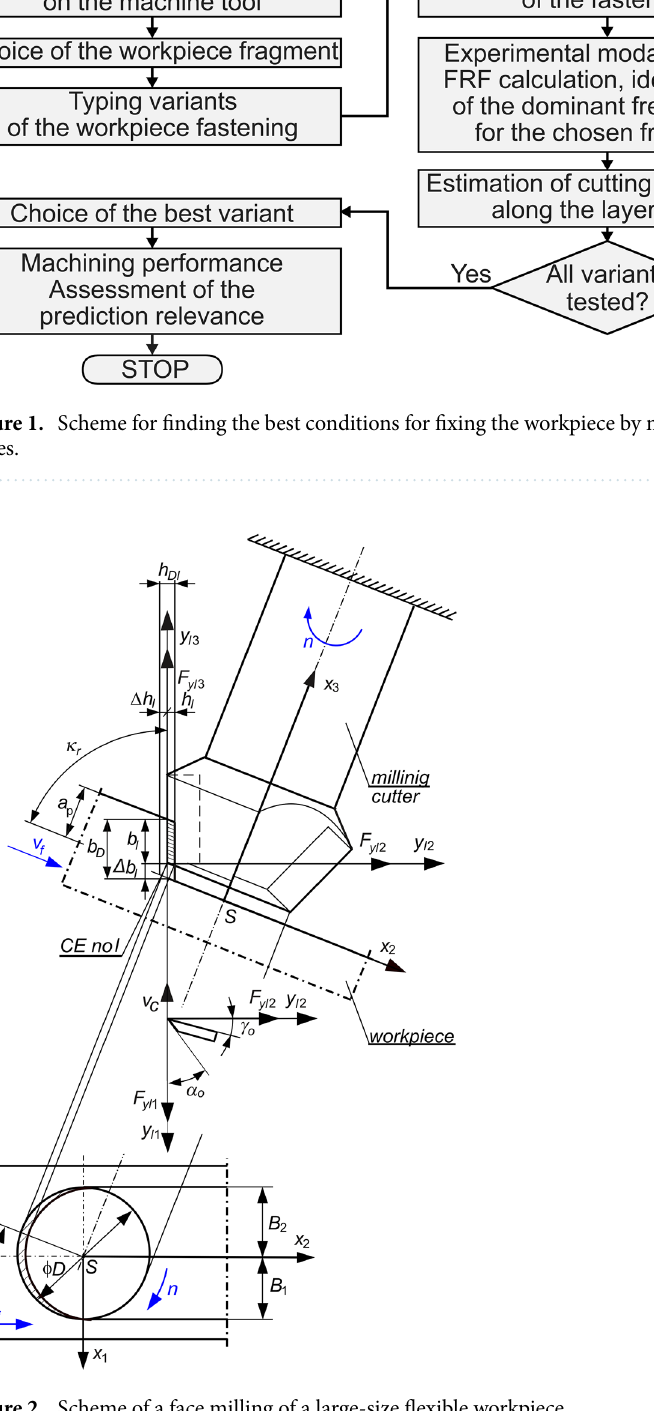
Figure 2. Scheme of a face milling of a large-size flexible